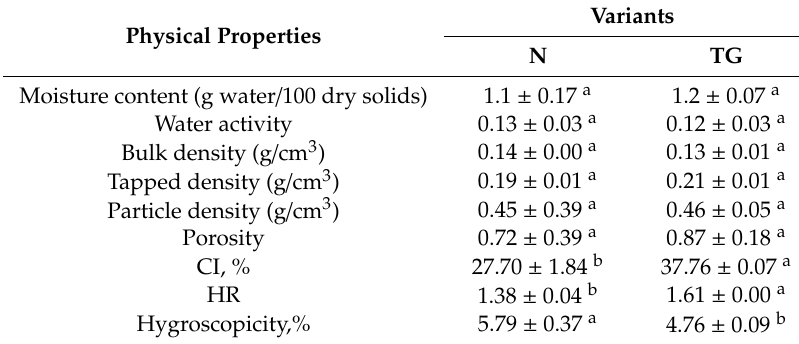
Table 1. Physical properties of